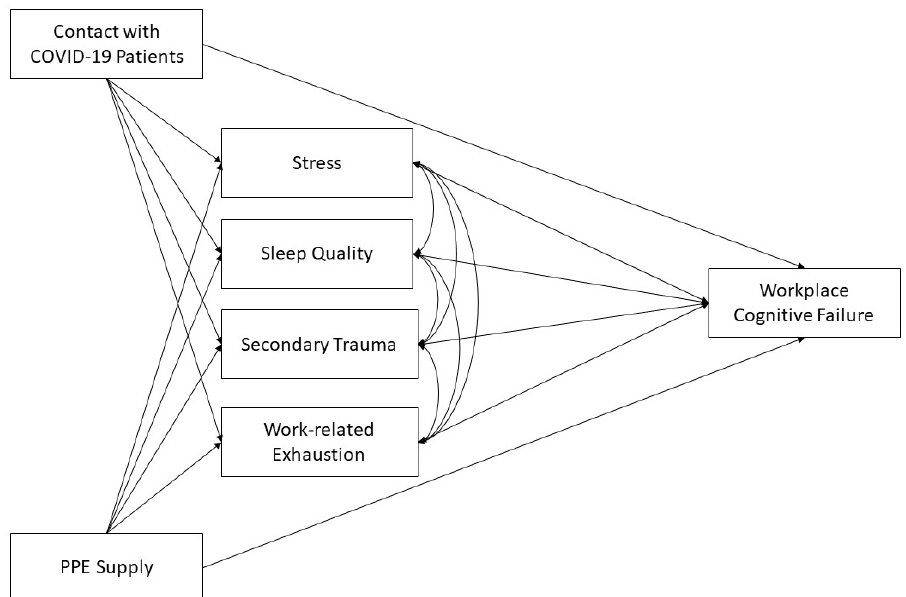
Figure 1. Conceptual model of hypothesized relationships between physical exposures and work- place cognitive failure and the mediating effects of psychosocial factors.